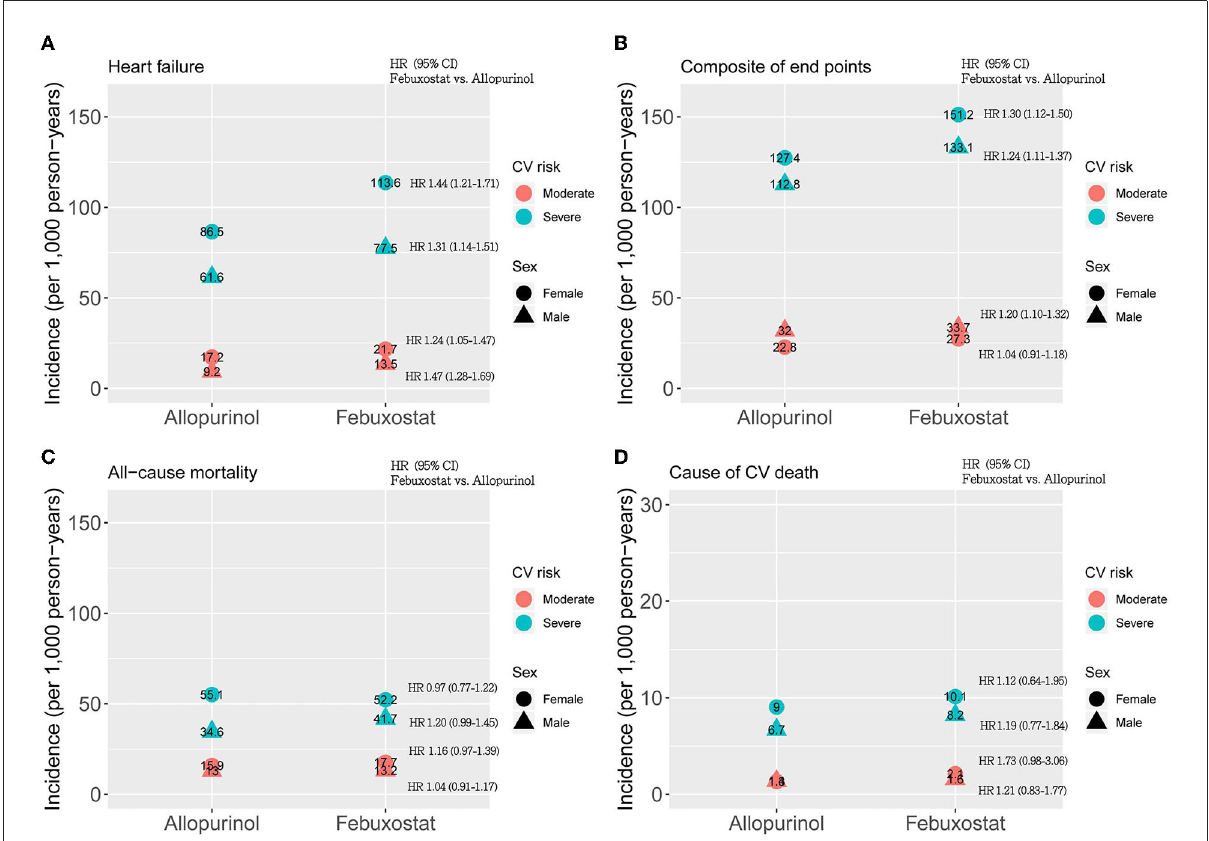
FIGURE2 Gender analysis for CV risk-specific hazard ratios of (A) heart failure, (B) composite of end points, (C) all-cause mortality, and (D) cause of CV death between patients taking allopurinol and febuxostat. The x-axis shows two drugs: allopurinol and febuxostat, and the y-axis shows the incidence rate per 1,000 person-years. The circles and triangles represent female and male patients, respectively. The red dots represent moderate CV risk, and the blue dots represent severe CV risk. HR represents the hazard ratio. The hazard ratios were estimated in the same strata (the same sex and CV risk groups) for febuxostat users compared to allopurinol